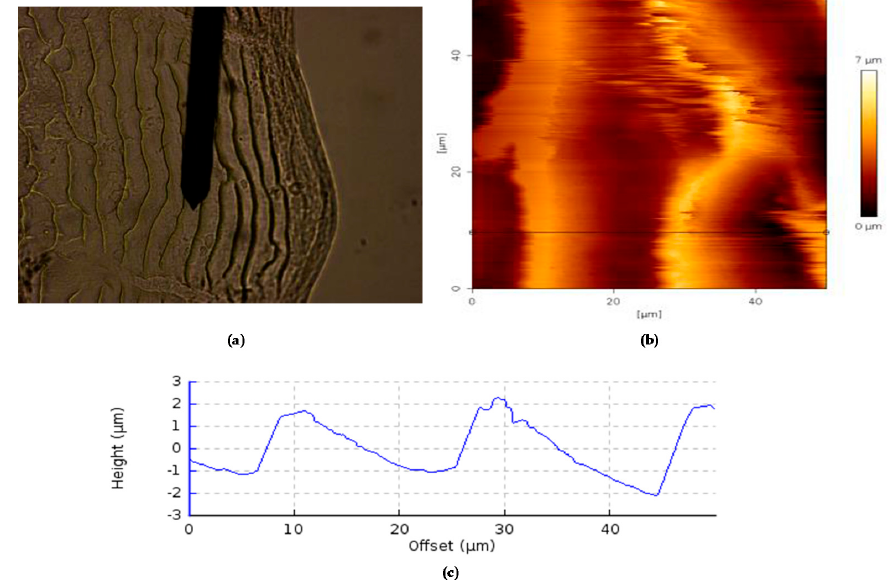
Figure 4. Image of a representative gilthead seabream scale studied with atomic force microscopy (AFM). ( a ) Optical image of the rostral field of a scale from region 1, withthe black spike being the cantilever signaling the area about to be measured. ( b ) Map generated with AFM of the area under the cantilever in ( a ). ( c ) Topographic profile measured along the black line in B, where the height and length of the structures can be quantified.